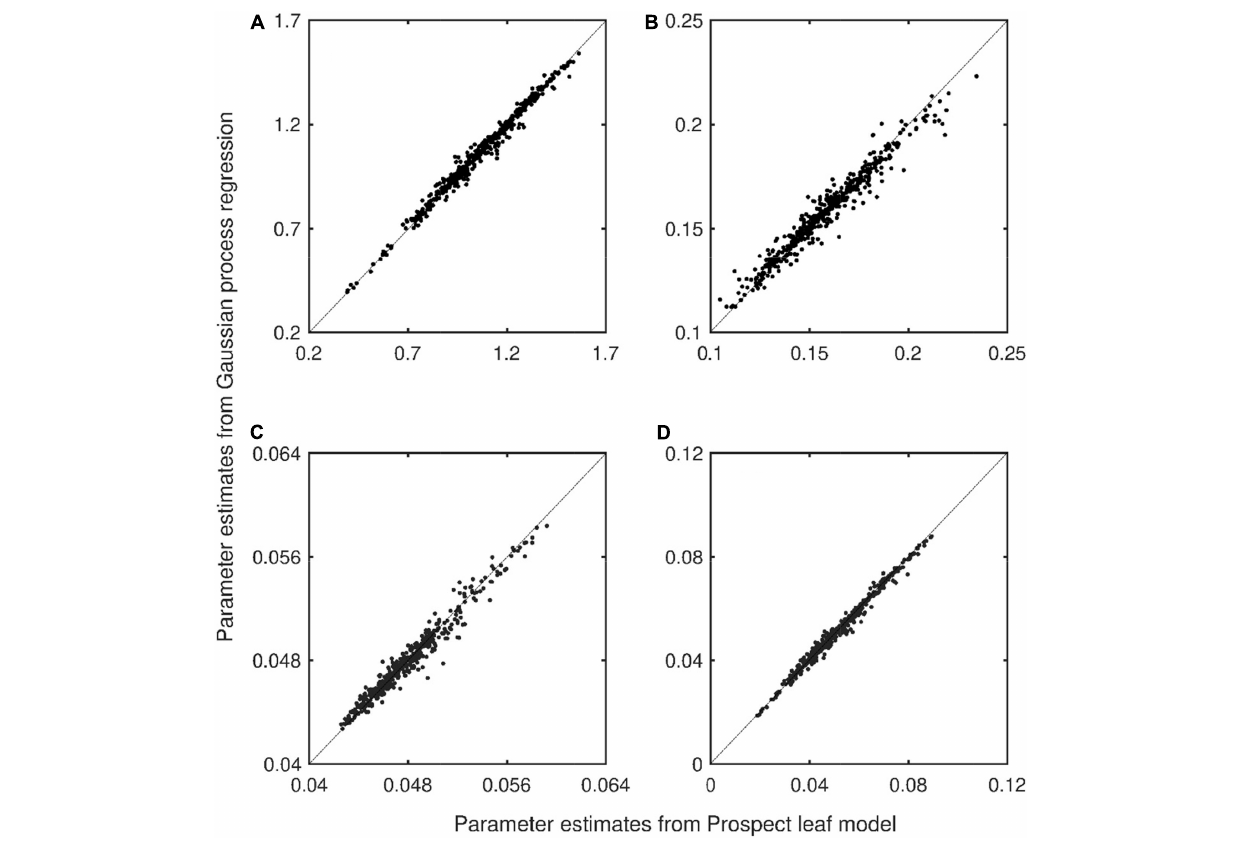
Frontiers in Plant Science |